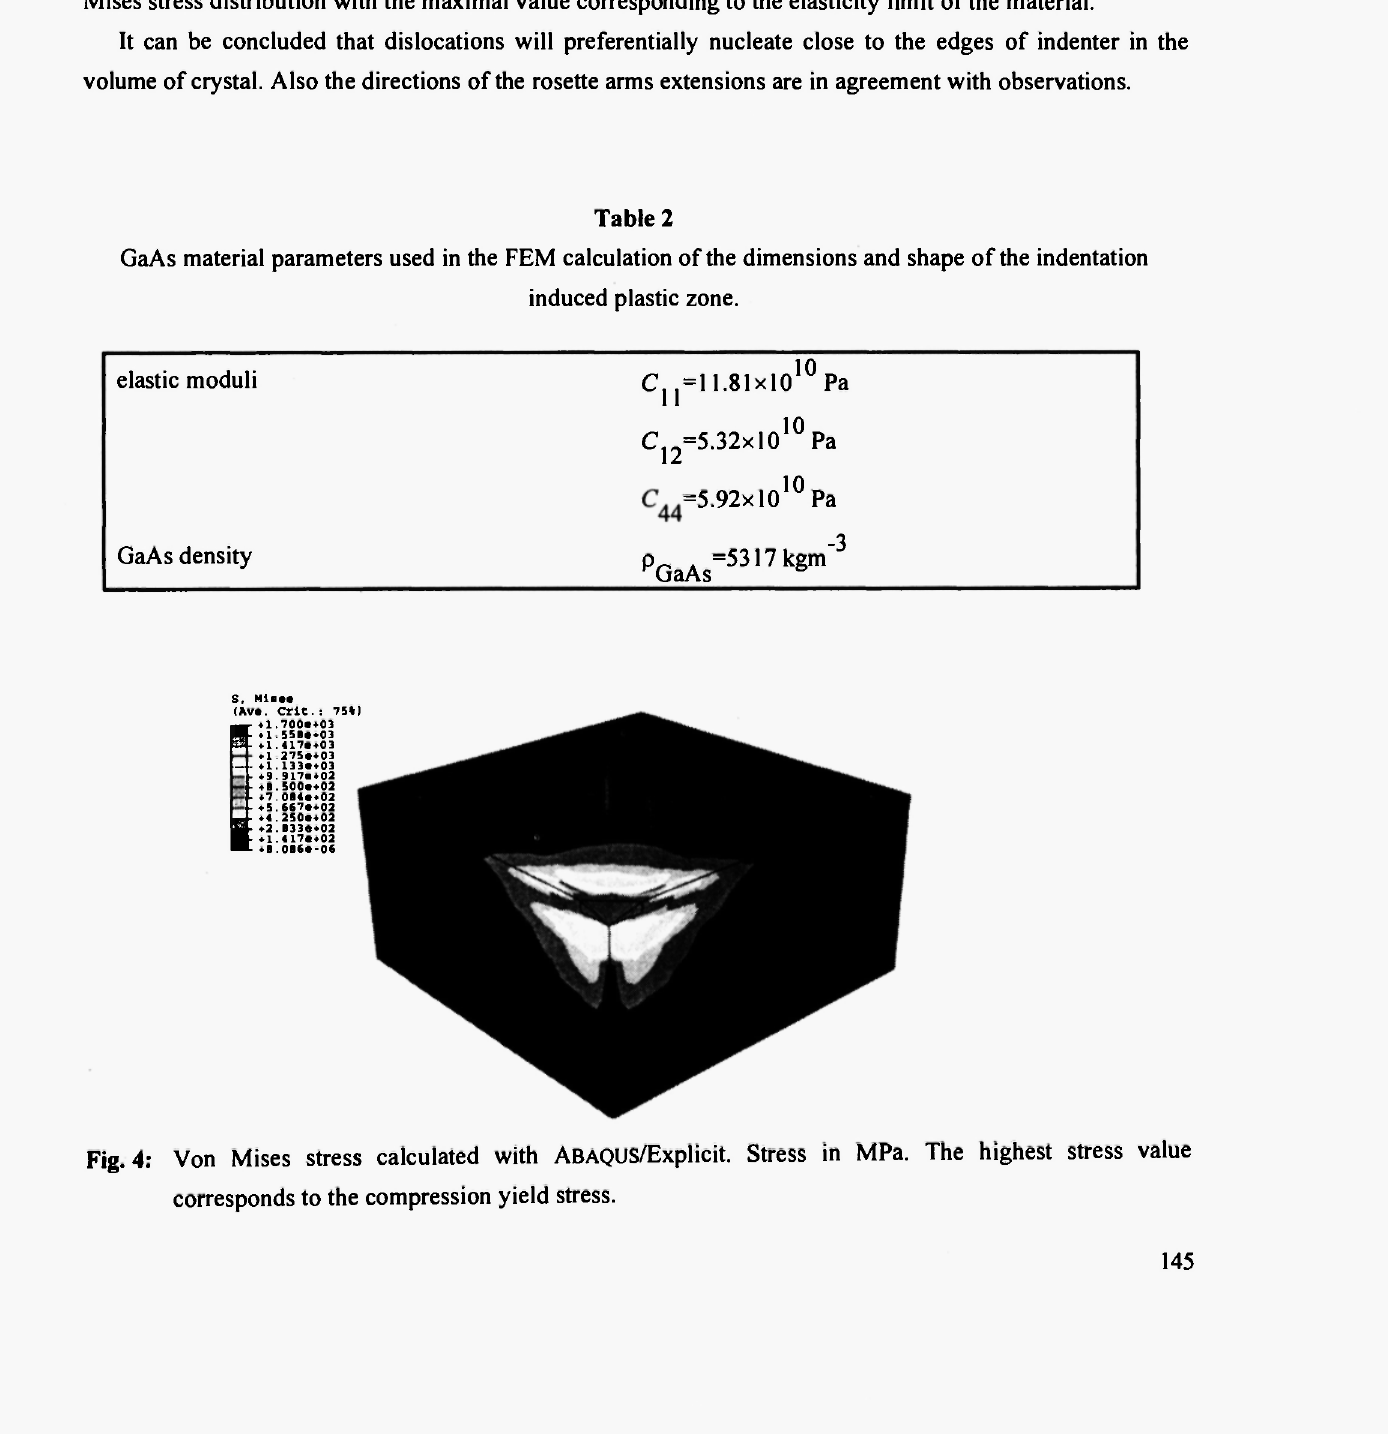
Fig. 4: Von Mises stress calculated with ABAQUS /Explicit. Stress in MPa. The highest stress value corresponds to the compression yield